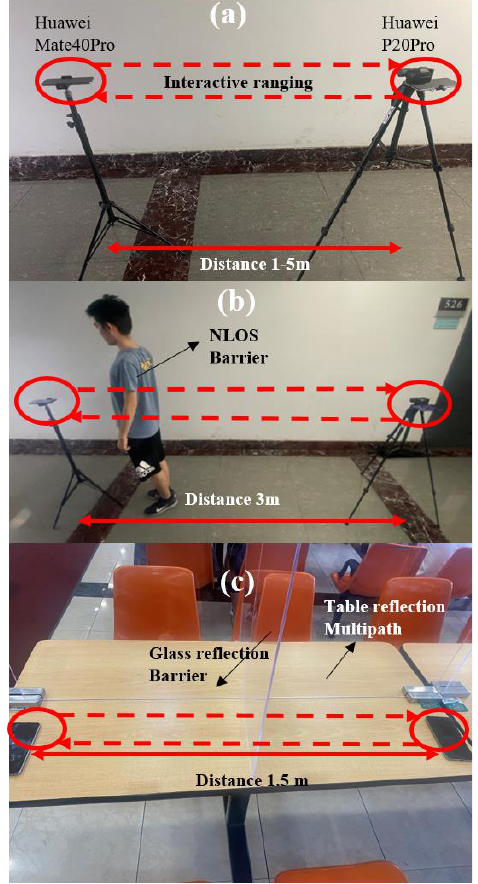
Figure 19. Three cases of experiments. ( a ) LoS. ( b ) NLoS, the cover is the human body. ( c ) NLoS in a canteen, the cover is glass. canteen, the cover is